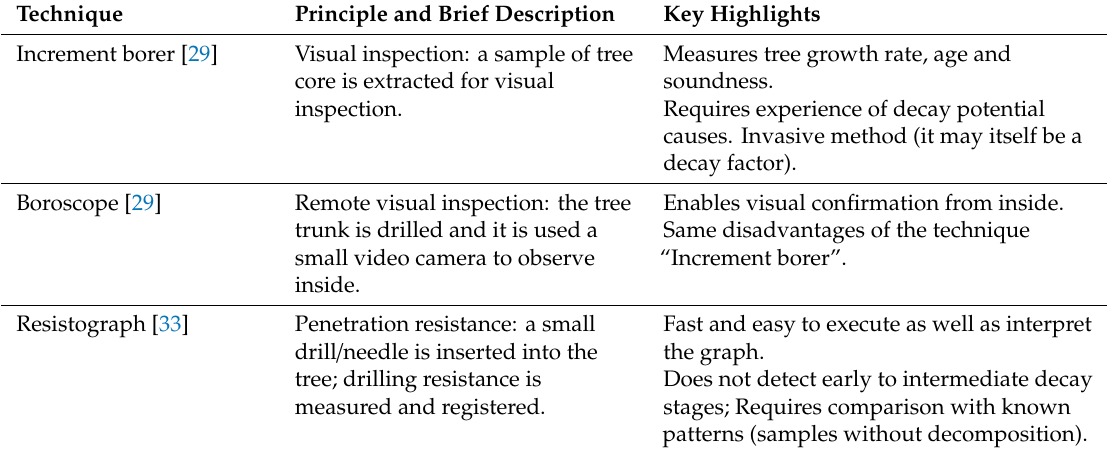
Table 2. A short summary of the techniques for detecting trees deterioration. Technique Principle and Brief